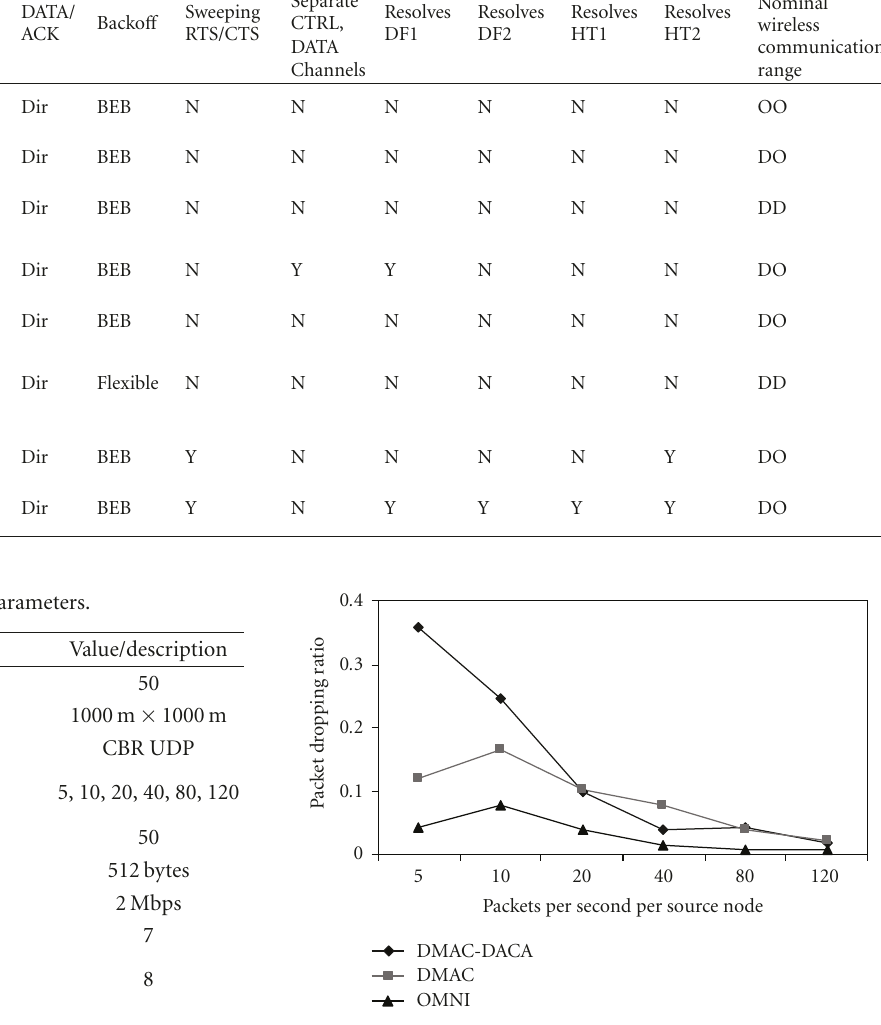
Figure 18: E ff ect of DMAC-DACA’s CA